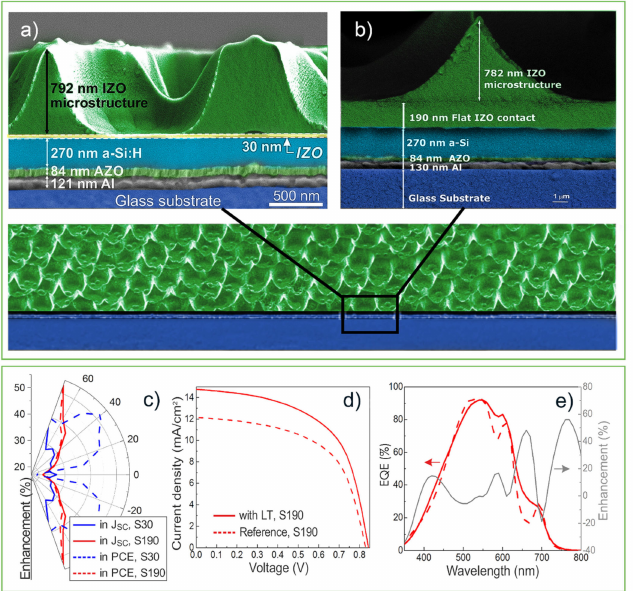
Figure 13. SEM cross-sections of a-Si:H solar cells with two different thicknesses of the flat IZO layer (30 ( a ) and 190 nm ( b ), respectively) located between the a-Si: H absorber and the front LT structures; ( c ) Polar plot representing the angular response of the solar cells with 30 nm, S30 (blue lines), and with 190 nm of IZO thickness, S190 (red lines), in terms of the gains attained in the short-circuit current density, (J SC , solid lines) and power-conversion efficiency (PCE, dashed lines) of the cells; ( d ) J-V curves and ( e ) external quantum efficiency obtained for S190 (190 nm of IZO thickness). Adapted with permission from [29]. Copyright 2021